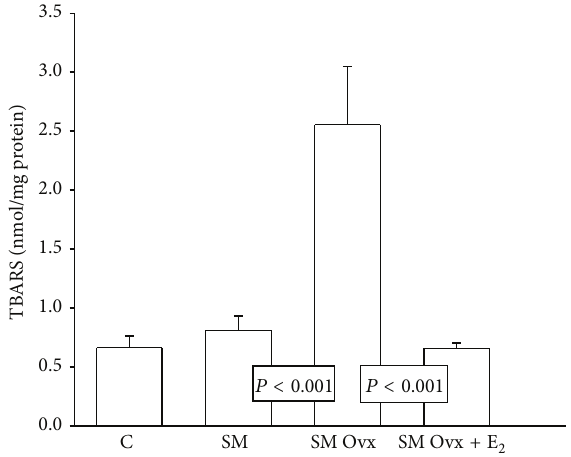
Figure 5: Lipid peroxidation was measured in adipocyte homoge- nate. See Table 1 legend for abbreviations. Values are means ± SE; 𝑛 = 8 each group.